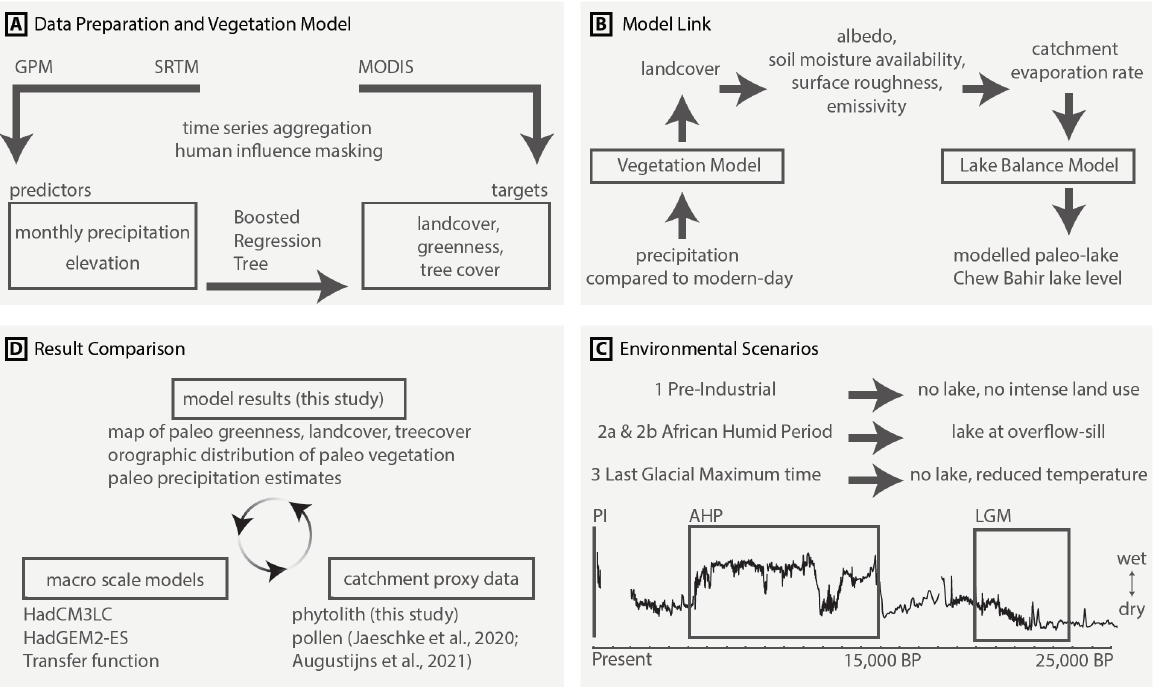
Figure 2. Summary of methods in this study. ( A ) Dataset collection: Modern Global Precipitation Measurement (GPM), Shuttle Radar Topography Mission (SRTM) elevation data, Moderate Resolution Imaging Spectroradiometer (MODIS) vegetation and landcover data. Dataset preparation included time series aggregation from 2001 to 2018 with human influence masked using Open Street Maps, and Boosted Regression Tree model training. ( B ) Vegetation and LBM link using precipitation as input to predict landcover, resulting surface parameters and ET based on [75], the resulting lake balance of lakes Abaya, Chamo and paleo-lake Chew Bahir and, hence, the lake surface elevation of paleo-lake Chew Bahir. ( C ) Three different environmental scenarios are applied in this study: Pre-Industrial time with modern-day climate, reduced or eliminated human influence and to be modelled potential landcover, and AHP and LGM time based with major assumption for this model. All three scenarios are visible in the Potassium record in the lacustrine sediments of paleo-lake Chew Bahir [33]. ( D ) Comparison with global paleo reconstructions (macro scale) and catchment (small scale) proxy-based reconstructions including the phytoliths from the current